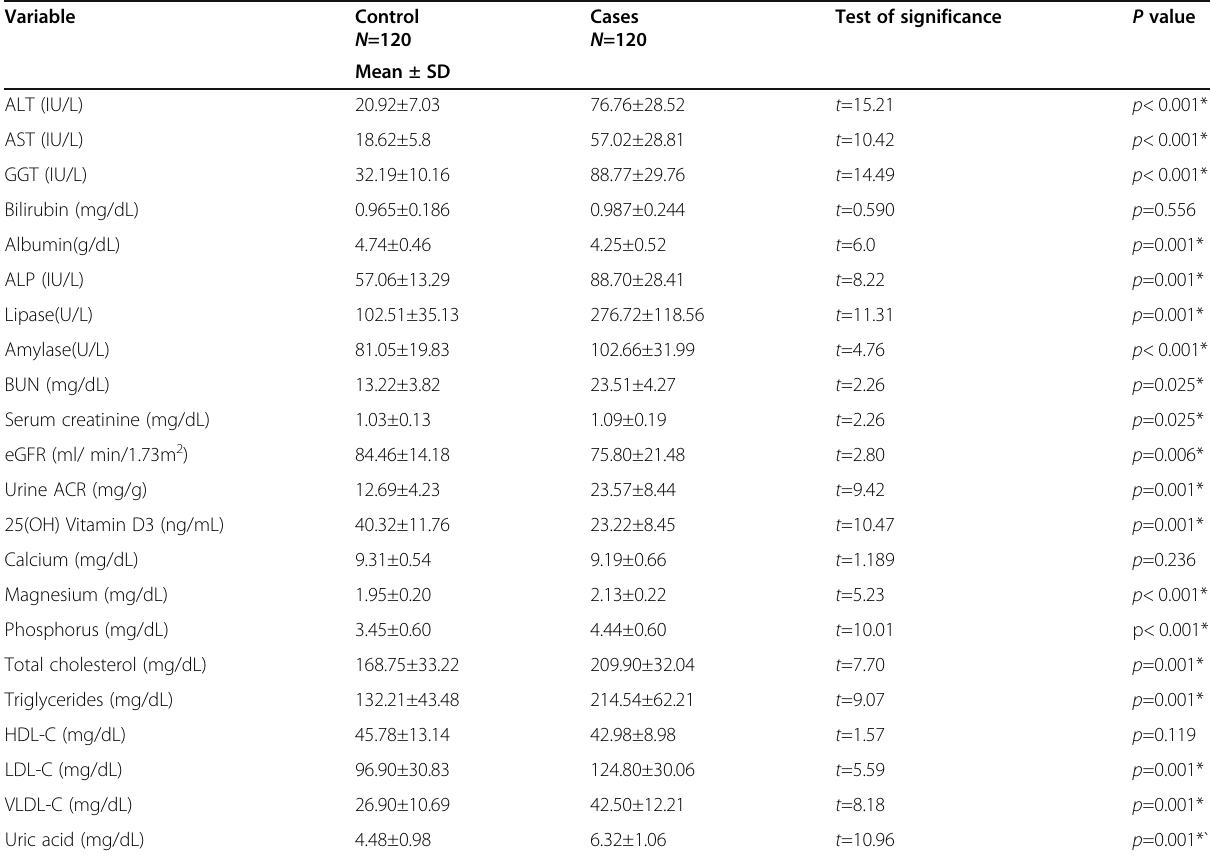
Table 3 Biochemical findings of the study groups